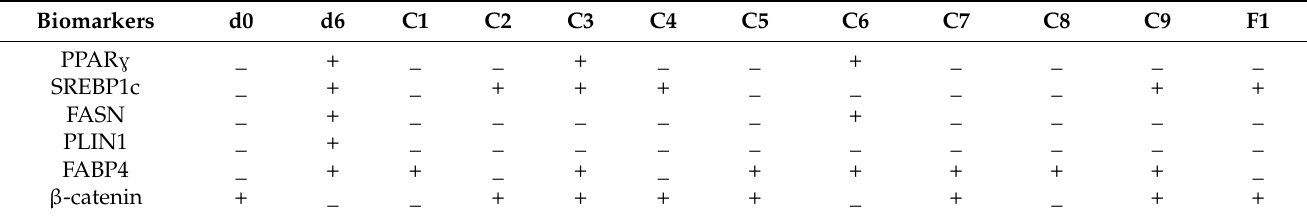
Table legend: d0: pre-differentiation; d6: post-differentiation; d6 post-differentiation in the presence of C1: berberine; C2: luteolin; C3: resveratrol; C4: fisetin; C5: quercetin; C6: fucoidan; C7: EGCG; C8: hesperidin; C9: curcumin; or F1: composition of C1–C9; _: low expression level; +: high expression